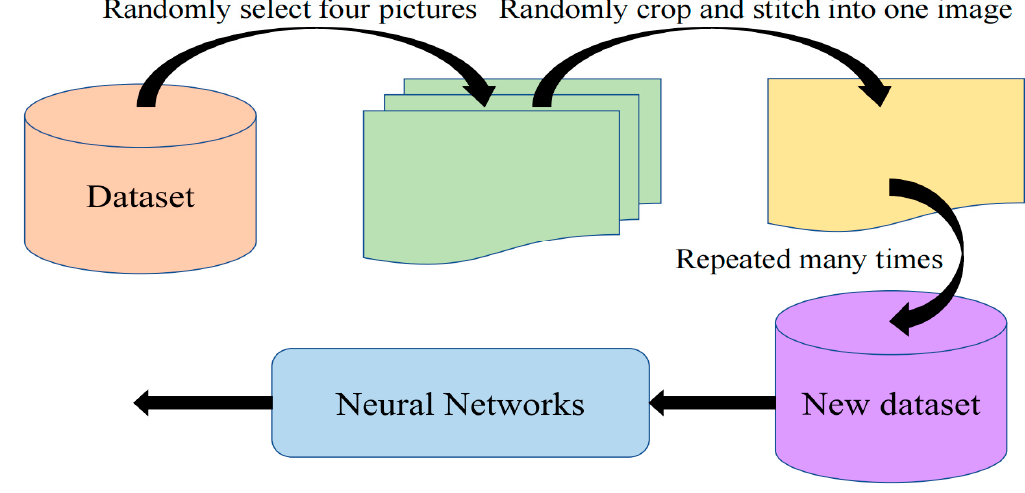
Figure 4. Mosaic data augmentation process.